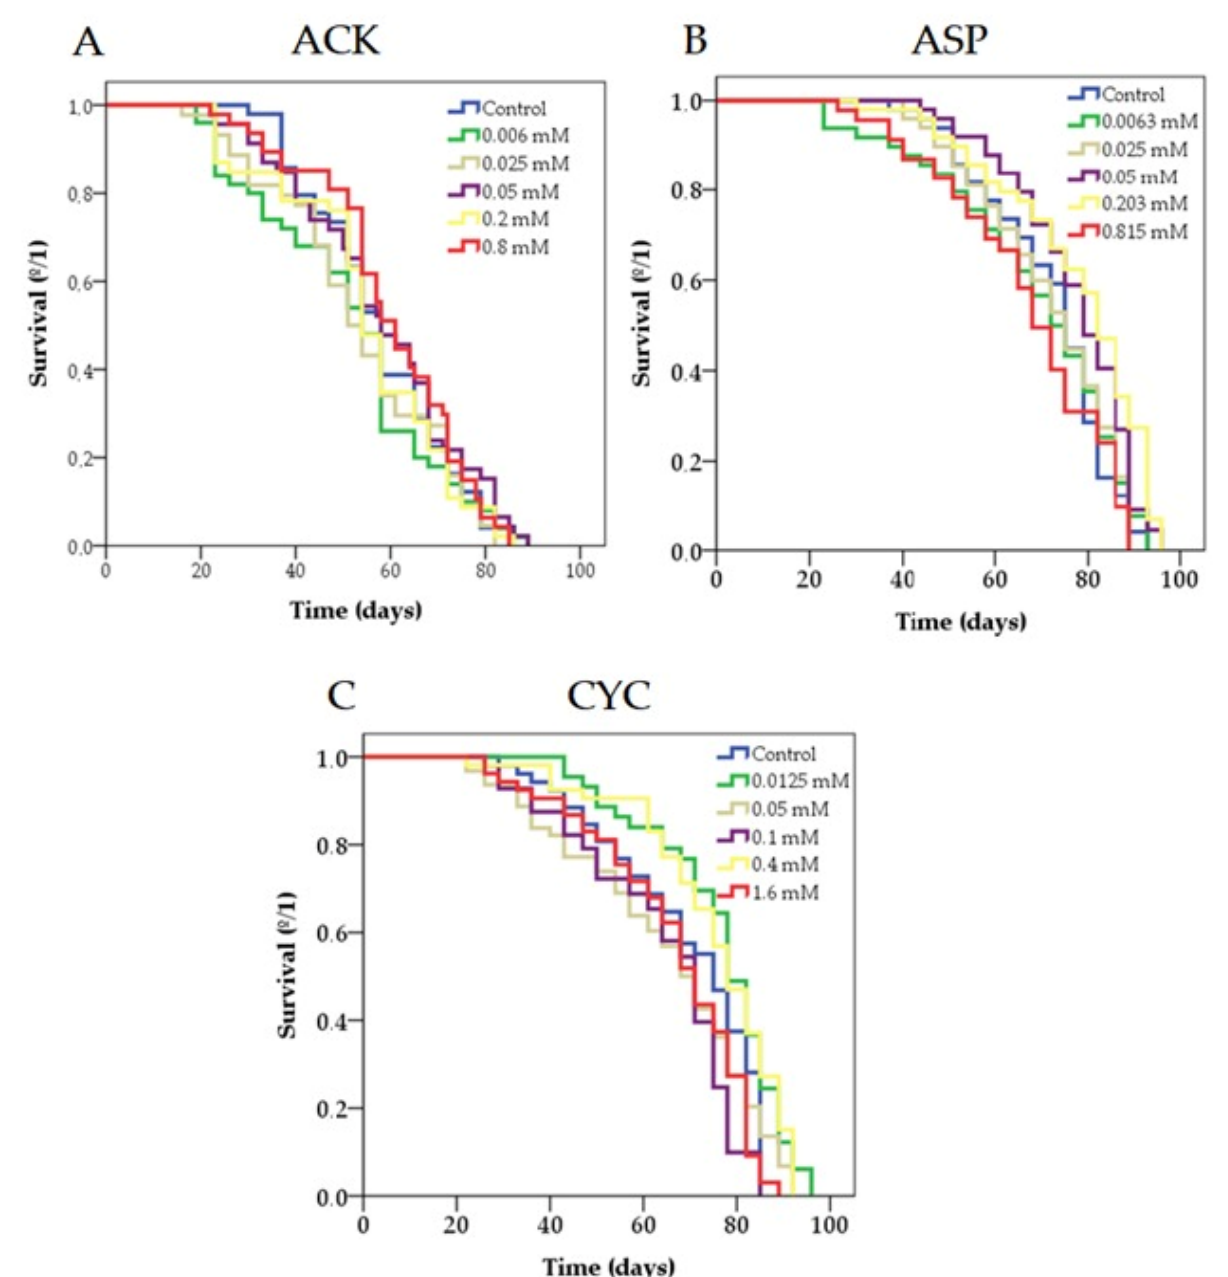
Figure 1. Effect of ASP ( A ), ACK ( B ) and CYC ( C ) supplementation on the lifespan of Drosophila melanogaster .